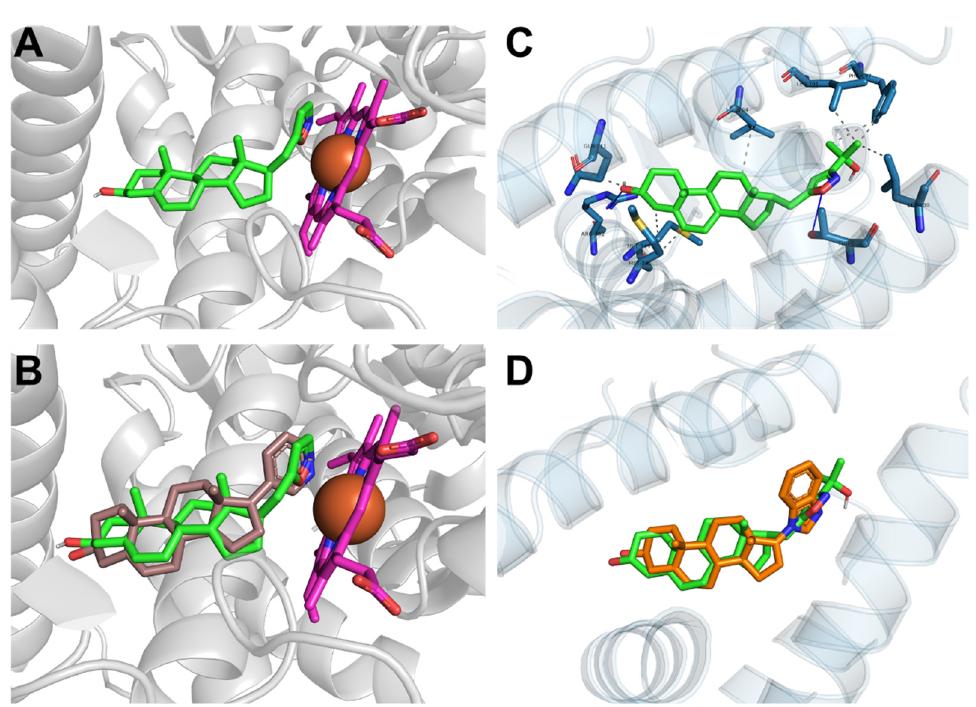
Figure 4 . ( A ) Model of the binding pose of 41a (green) in CYP17A1 (rigid docking into the PDB:3RUK) and ( B ) alignment of the binding pose with abiraterone (brown) from the original crystal structure. Heme is shown in magenta. ( C ) Model of the binding pose of 24j (green) in AR-LBD (flexible docking into the PDB:2PIV) with the interacting amino acid residues. Hydrogen bonds are shown as blue lines, and hydrophobic bonds are shown by gray dashed lines. ( D ) Alignment of binding pose of 24j with the galeterone (orange) binding pose from flexible docking.